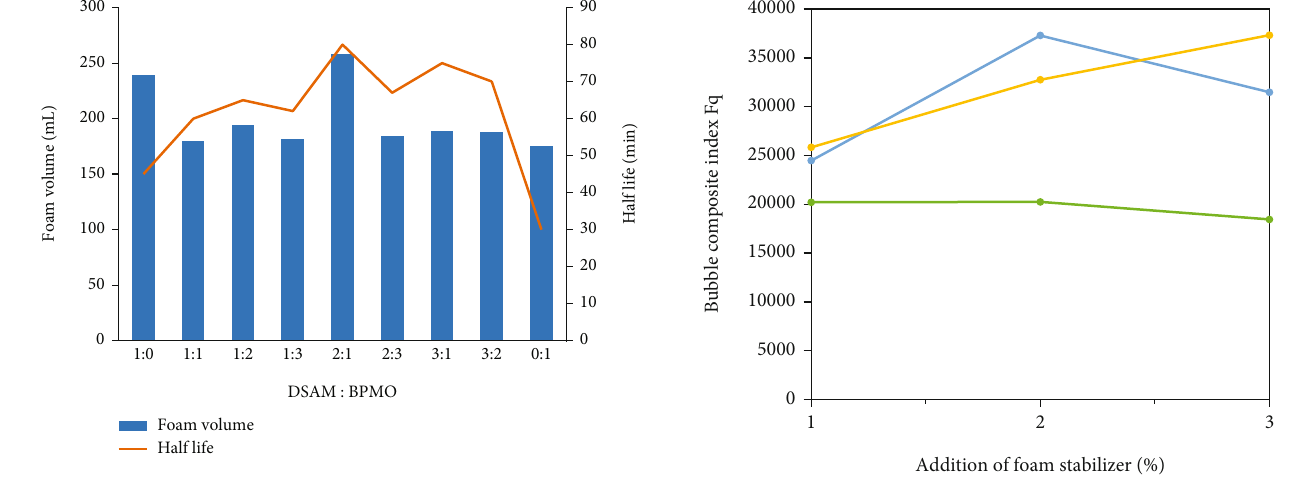
Figure 7: The foaming performance of the compound system of DSFA and BPMO in di ff erent proportions.